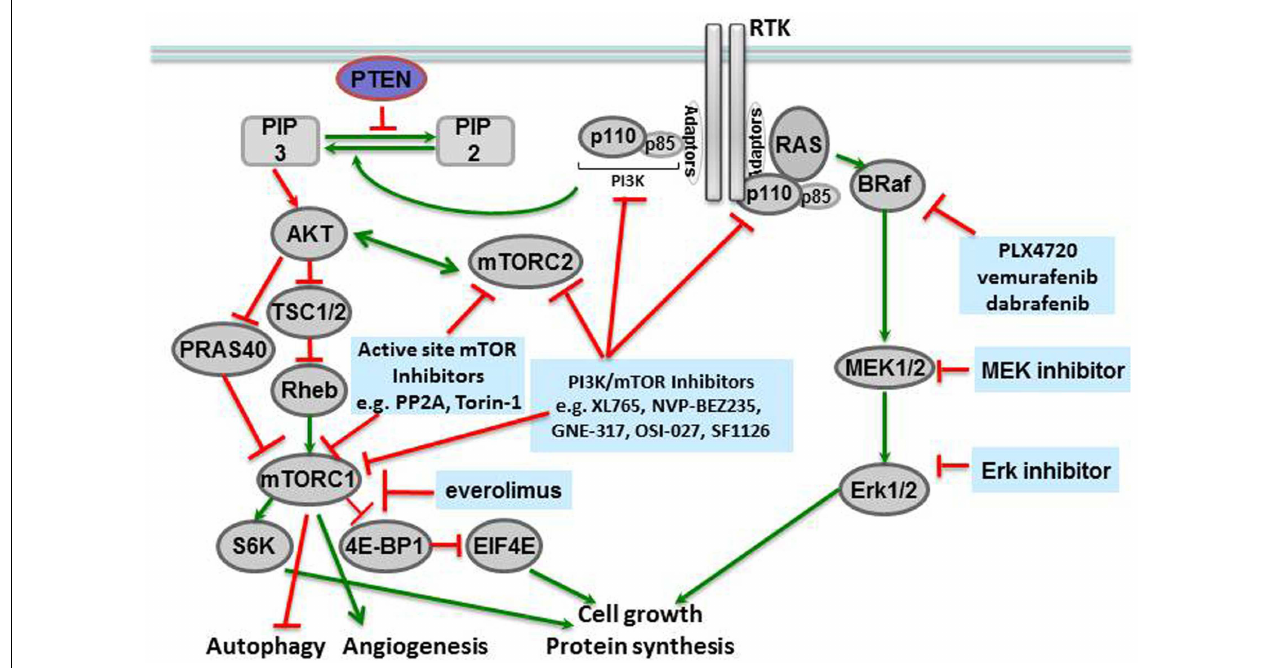
FIGURE 1 | Novel targeted agents and the pathways inhibited in solid tumors